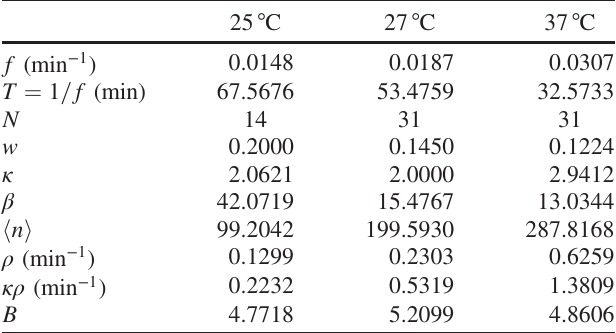
TABLE III. The medians of the estimated parameters for all cell lineages at three different temperatures. The distributions of the estimated parameters can be found in Figs. S4 and S5 in the Supplemental Material [66]. The medians rather than the means are reported here since the estimation of the former is more robust than that of the latter, with respect to outliers.